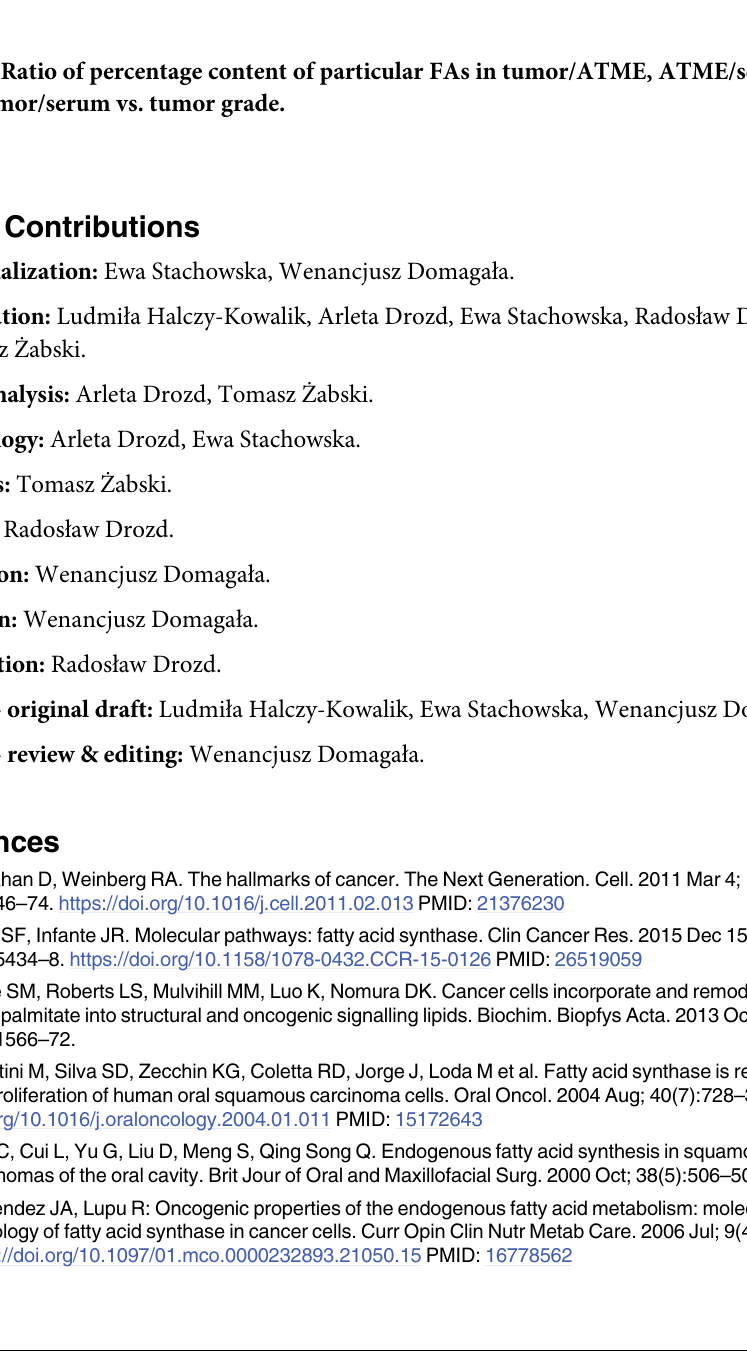
S2 Table. Percentage of content of FAs groups: SFA, UFA, MUFA, series n3 of PUFA and ratios C18:2n6/C18:3n3, C20:4/(C20:5+C22:6n3) in tumor, ATME and blood serum vs .